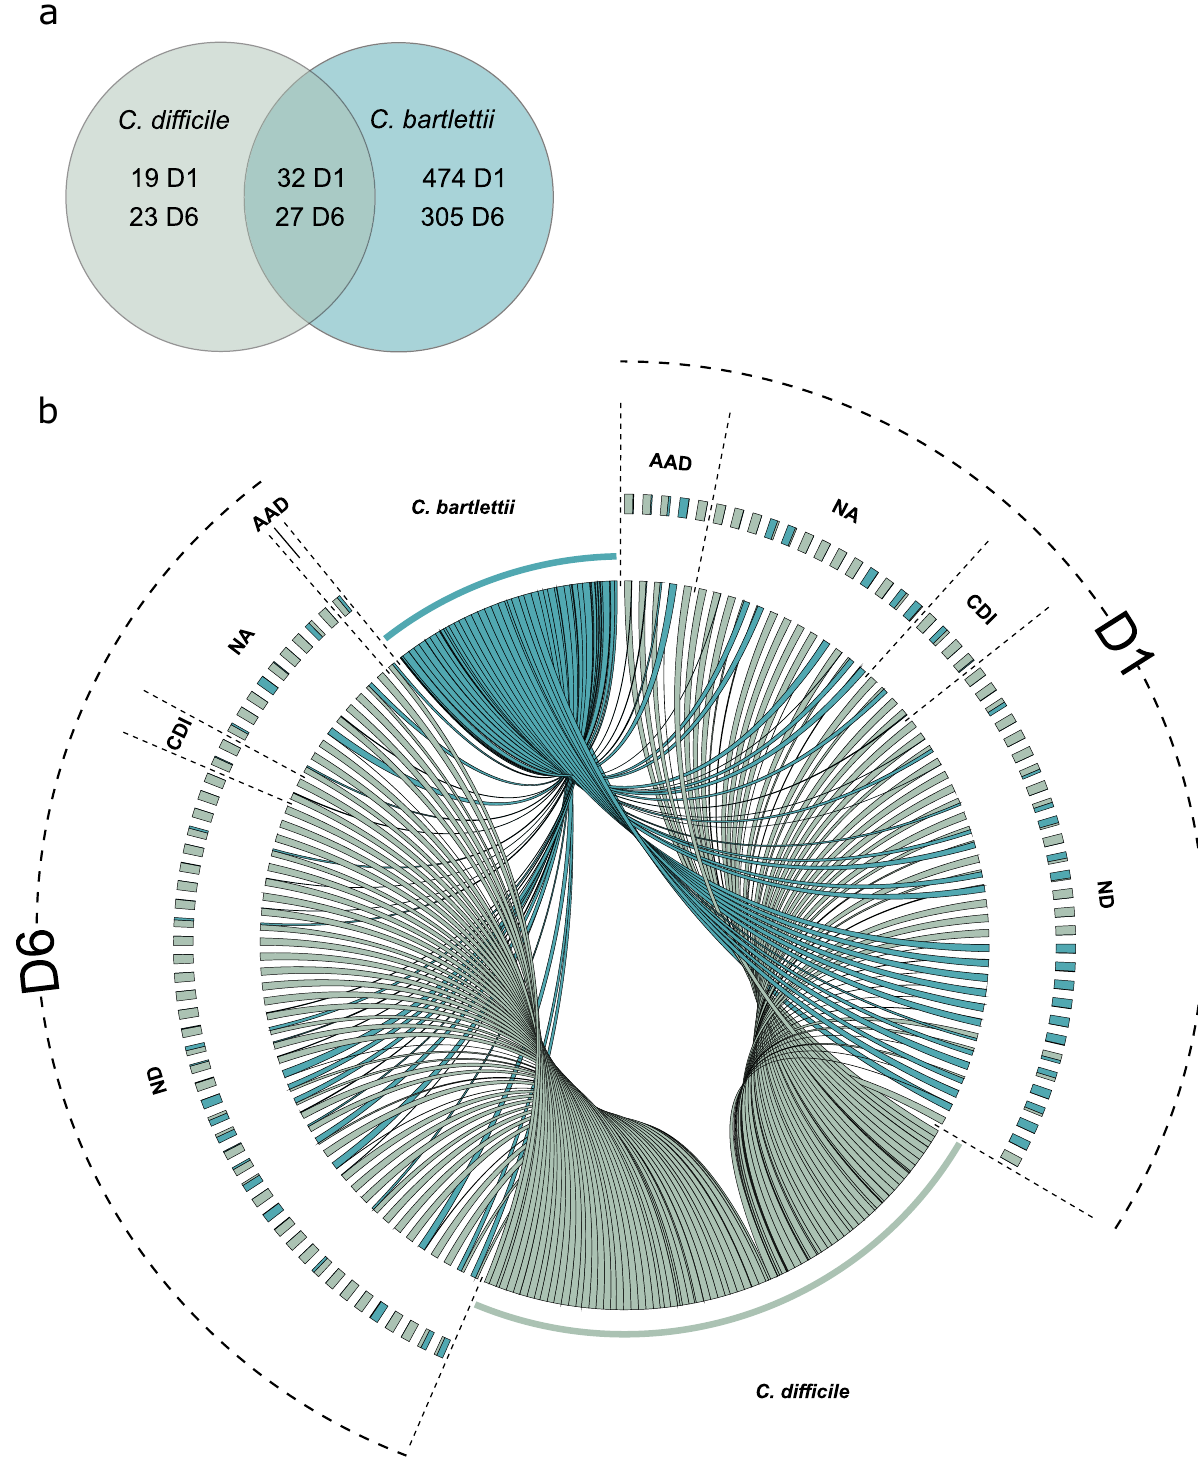
Fig. 2 C. dif fi cile and C. bartlettii carriage in the analyzed population at D1 and D6. Oligotyping revealed diversity within the OTU classi fi ed as Clostridium XI wherein reads were divided into C. dif fi cile (green) and C. bartlettii (blue). a Rectal swab samples collected at the time of study enrollment (D1), and ~6 days later at the end of treatment (D6) harbored reads classi fi ed as both C. dif fi cile and C. bartlettii . Patients that were de fi ned as C. dif fi cile carriers due to the presence of C. dif fi cile reads after oligotyping showed no clear link to clinical outcome. b Similar carriage rates of the OTU Clostridium XI were identi fi ed in patients both at D1 (5.40%, n = 51) and D6 (6.78%, n = 50) with varying relative abundances of C. dif fi cile and C. bartlettii reads as demonstrated in the Circos plot. Patients at D6 generally show higher relative abundance of C. dif fi cile than of C. bartlettii compared to D1. D1: rectal swab sample collected upon study enrollment. D6: rectal swab collected ~6 days after initiation and at the end of antibiotic treatment. AAD: patients with non- C. dif fi cile antibiotic-associated diarrhea. CDI: patients with con fi rmed C. dif fi cile infection. ND: non-diarrheic patients. NA: patients without known CDI status and/or early study termination. OTU: operational taxonomic